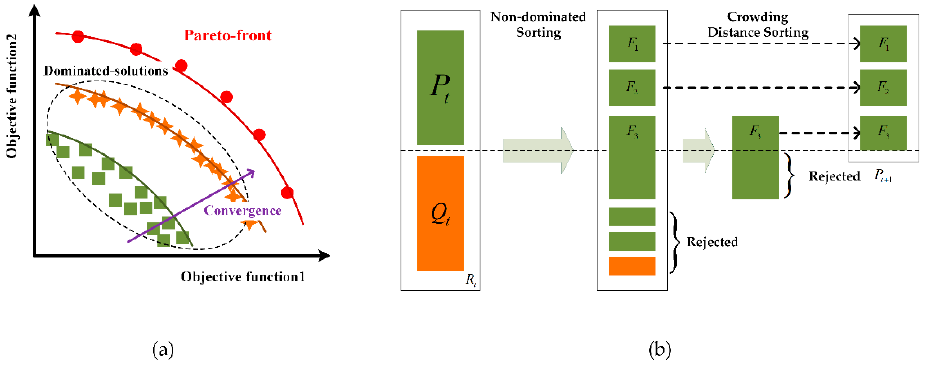
Figure 5. Conceptual diagram of ( a ) Pareto-front, and ( b ) NSGA-II.